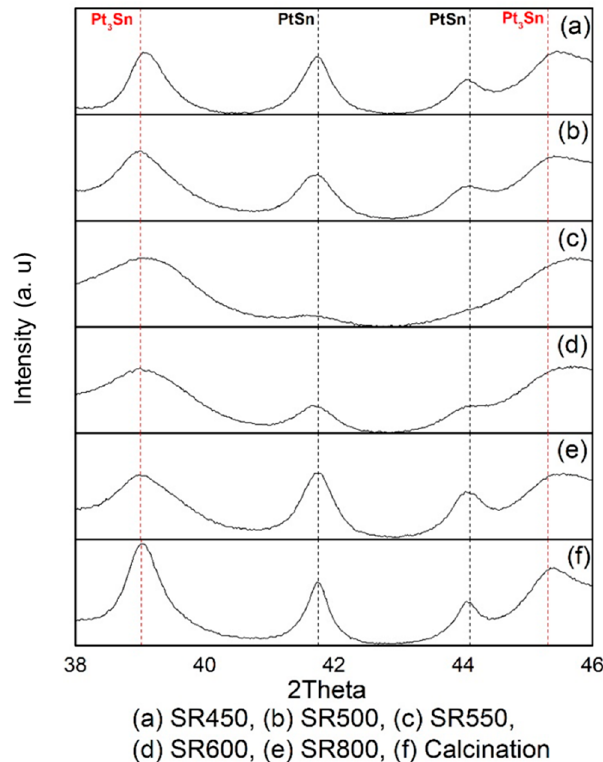
Figure 4. XRD patterns of Pt–Sn/Al 2 O 3 catalysts after pre-reduction at 600 °C for 1 h under a hydrogen atmosphere.